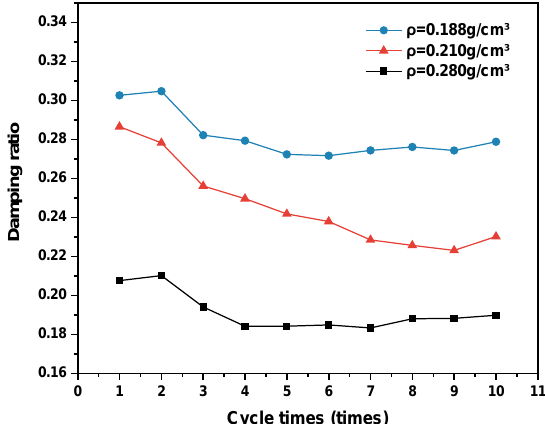
Figure 16. Development trends of damping ratios with different densities.